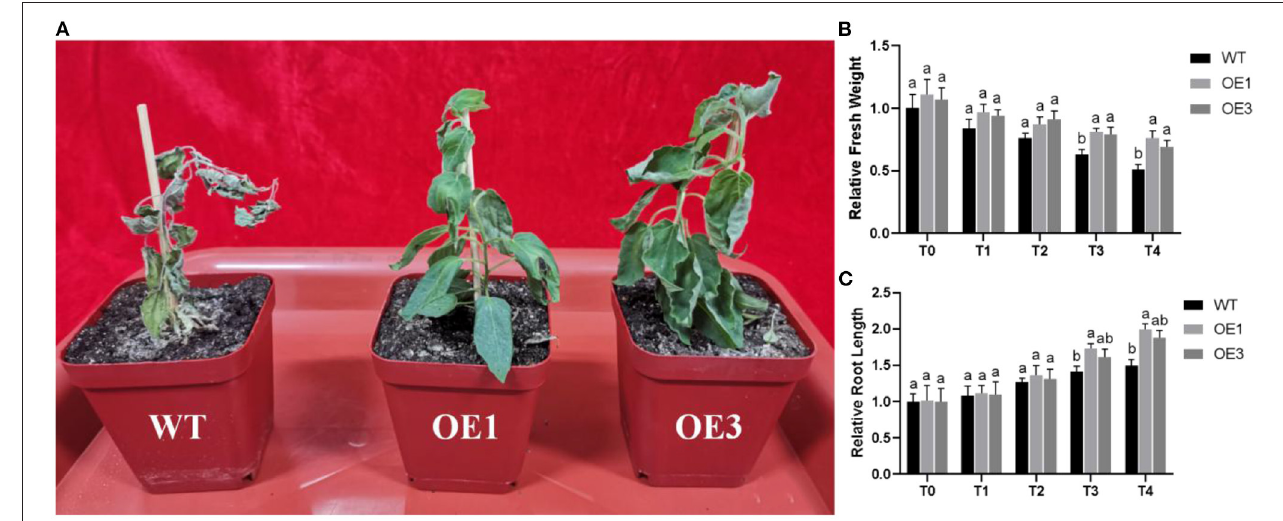
FIGURE 6 | (A) The growth status of WT and PdPapWRKY -overexpression putative transformants OE1 and OE3 lines inoculated with Fusarium oxysporum ; (B) Relative fresh weights of WT and transformants treated with F. oxysporum ; (C) Root lengths of WT and transformants treated with F. oxysporum . WT: wild type Pdpap; OE1, OE3: transformant lines. T0–T4: infection time was 0, 5, 10, 15, and 20 days. The error bars represented the standard deviation of the three independent replicates. Significant differences ( P < 0.05) were indicated by different lowercase letters.